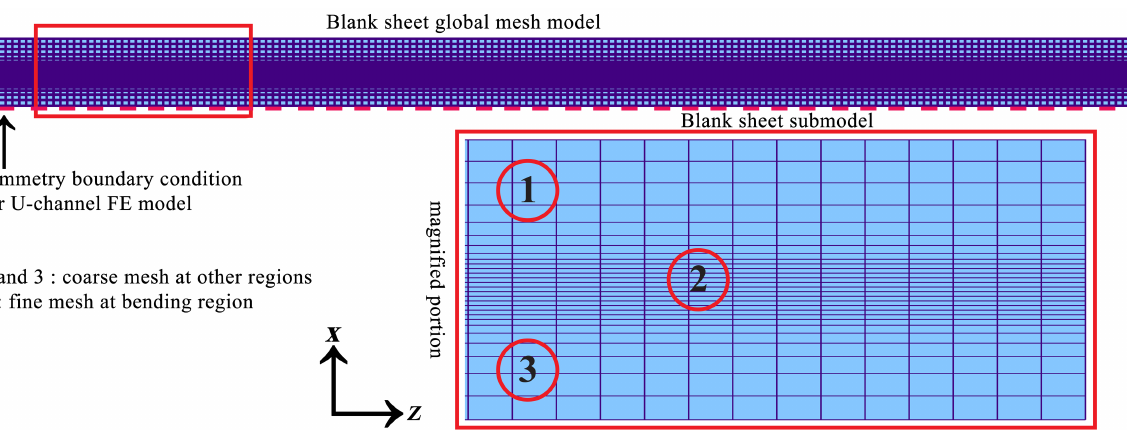
Figure 6. Strip before entering the first forming station defining boundary conditions and illustrating meshes